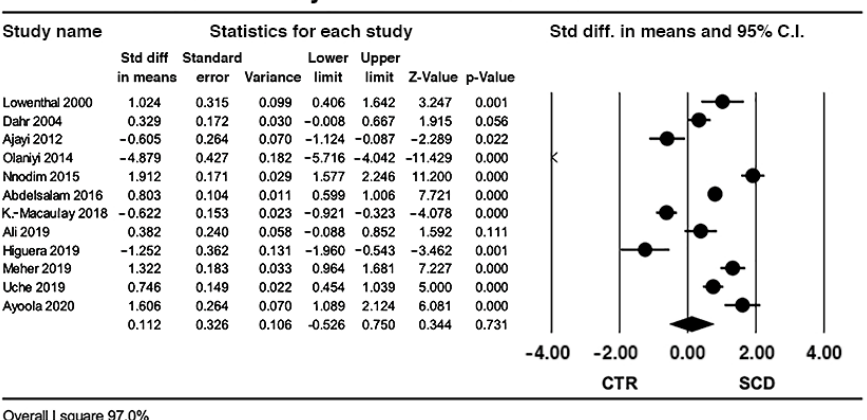
Figure 2. Effect size of studies comparing plasma homocysteine in control and adult sickle cell dis- ease. Table 4. Sensitivity analysis in the adult sickle cell disease/control comparison for plasma homocys- teine.